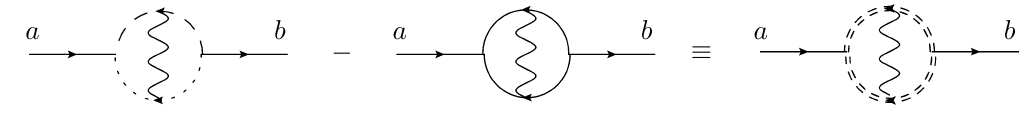
Figure 6 . In the di(cid:11)erence theory, the reducible diagrams that correct the ’ propagator at two loops can be expressed in terms of the one-loop contribution.